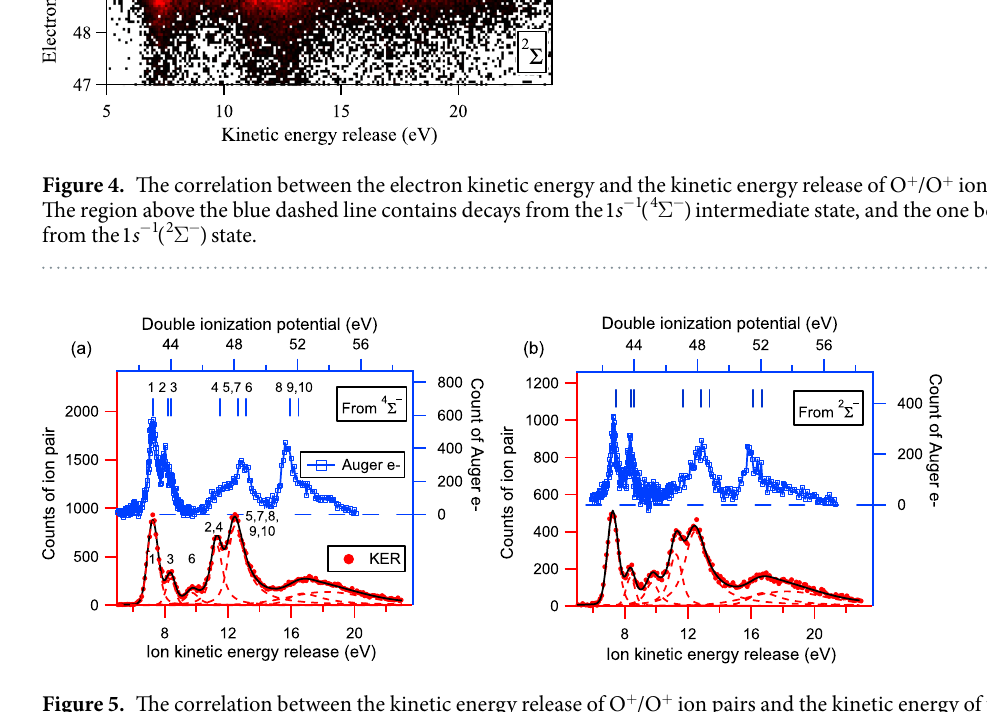
Figure 5. The correlation between the kinetic energy release of O + /O + ion pairs and the kinetic energy of the Auger electrons. ( a , b ) Correspond to the intermediate states of 4 Σ − and 2 Σ − , respectively. The Auger electron spectra are adapted from ref. 19. The labeling in ( a ) is adopted from Bao et al . 30 using numbers from 1 to 10. The labeling in ( b ) is neglected as it is the same as that in ( a ). The definition of labeling can be found in column 1 and 2 of Table 3.